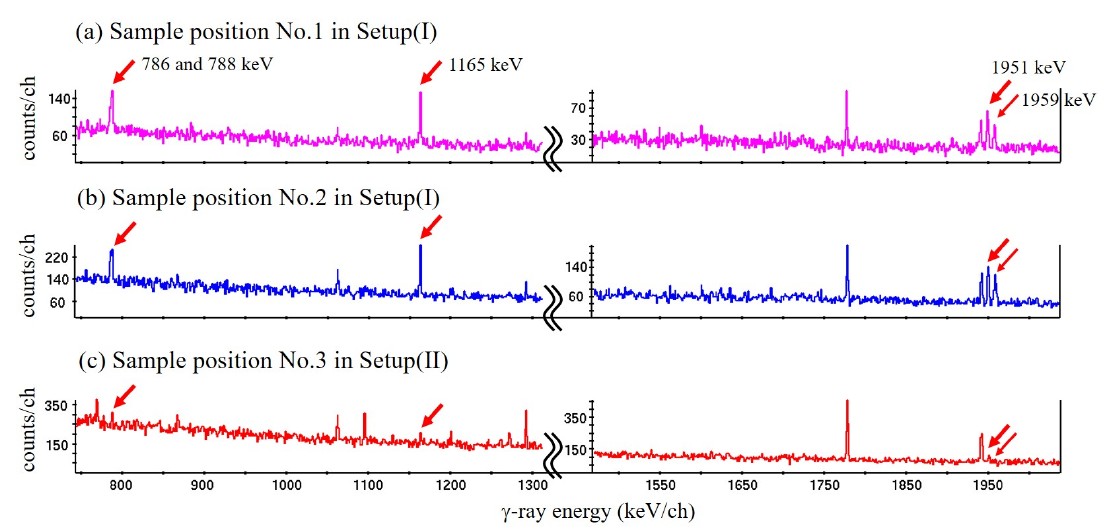
Figure 3 : Measured γ -ray spectra corresponding to sample positions. (a) sample position No.1 in Setup(I), (b) sample position No.2 in Setup (I), and (c) sample position No.3 in Setup (II). Arrows are γ -rays from 35 Cl(n, γ ) reaction. The 786 and 788 keV γ -rays can’t be separated clearly on this spectrum.